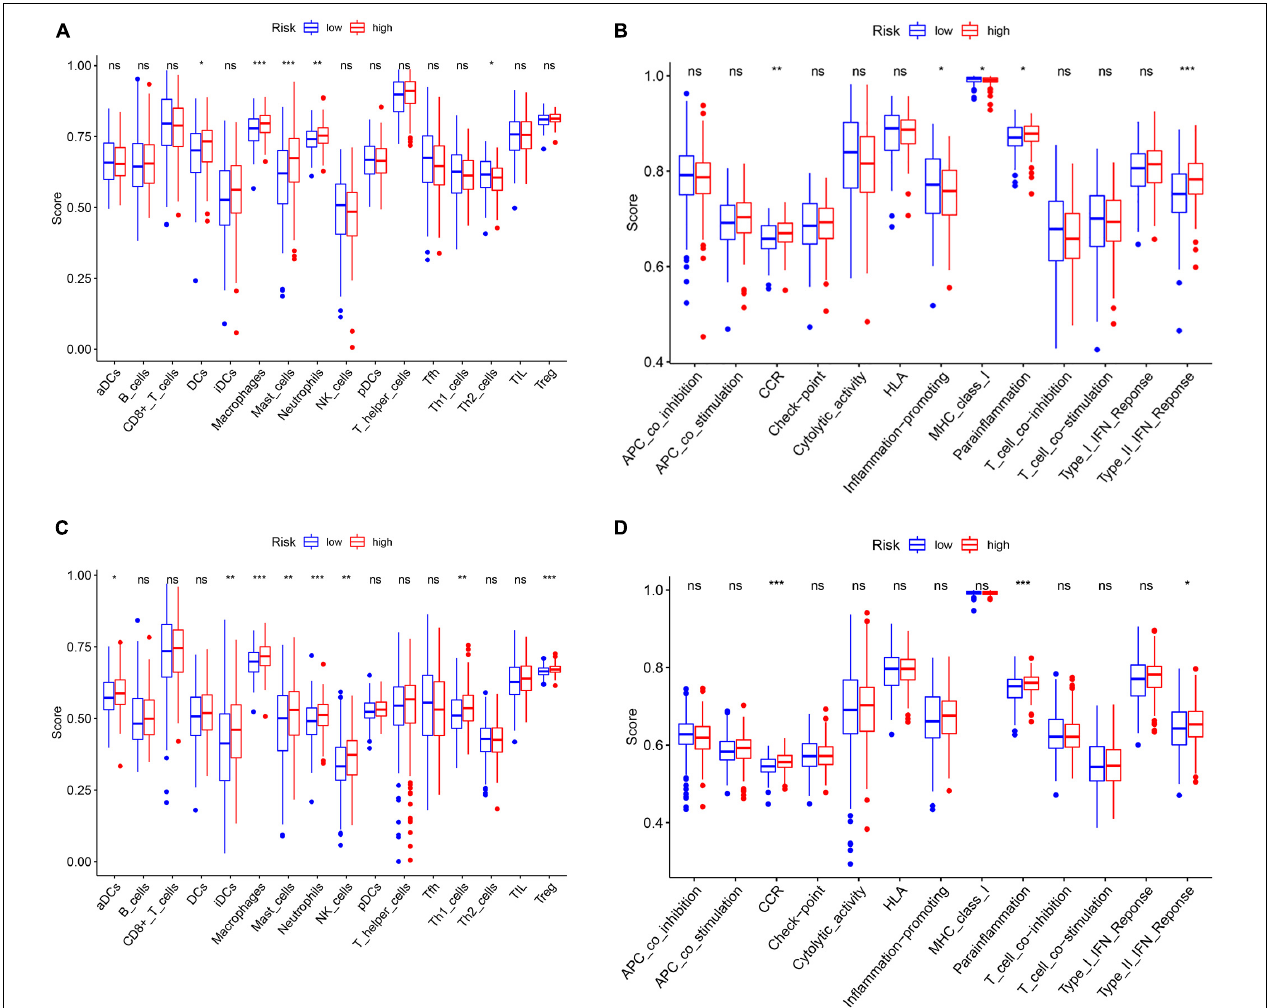
FIGURE 10 | Differences of immune cells infiltration and immune-related pathways between risk groups. (A) Immune cells and (B) immune-related functions in the TCGA cohort. (C) Immune cells (D) and immune-related functions in the GEO cohort. ns: not significant; * p < 0.05; ** p < 0.01; *** p <